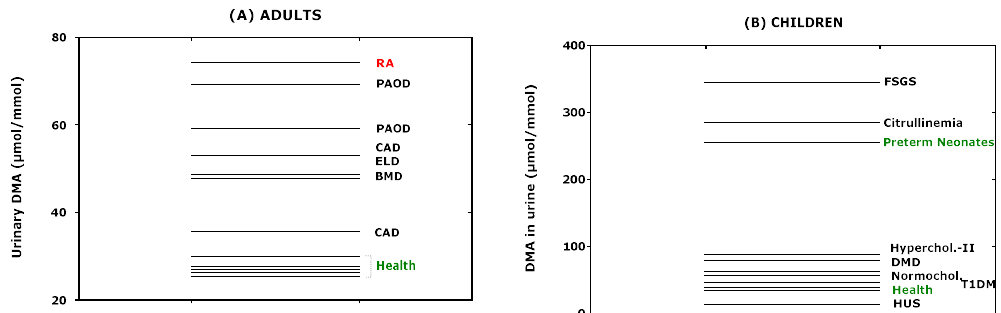
Figure 7. Creatinine-corrected excretion rates of dimethylamine (DMA) of the data taken from Table 1 for ( A ) adults and ( B ) neonates, children and adolescents. RA, rheumatoid arthritis; PAOD, peripheral arterial occlusion disease; CAD, coronary artery disease; ELD, end-stage liver disease; BMD, Becker muscular disease; FSGS, focal segmental glomerulosclerosis; DMD, Duchenne muscular disease; HUS, haemolytic-uraemic syndrome; T1DM, type 1 diabetes mellitus. Circulating and urinary ADMA and SDMA are considered cardiovascular risk factors in adults.